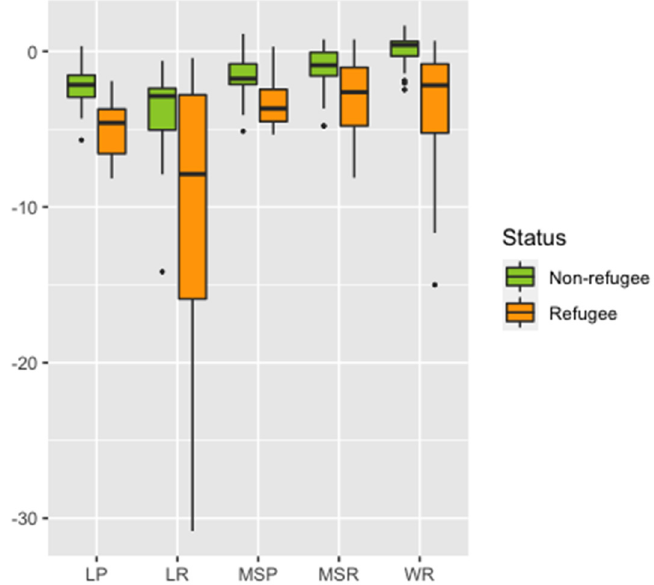
Figure 5. Distribution of bilingual refugee and non-refugee children’s z-scores to the standardized language tasks: lexical Production (LP), lexical reception (LR), morphosyntactic production (MSP), morphosyntactic reception (MSR), word repetition (WR).